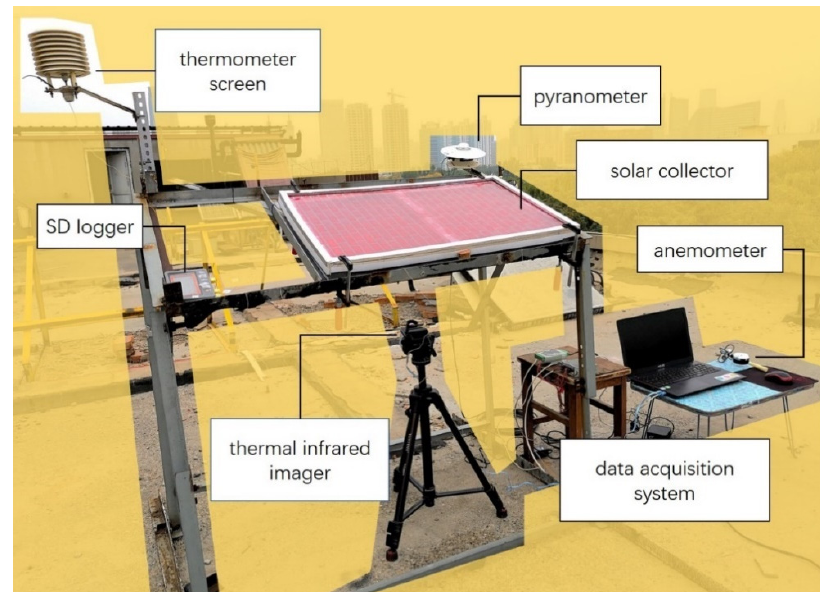
Figure 4. The experimental apparatus and testing instruments.